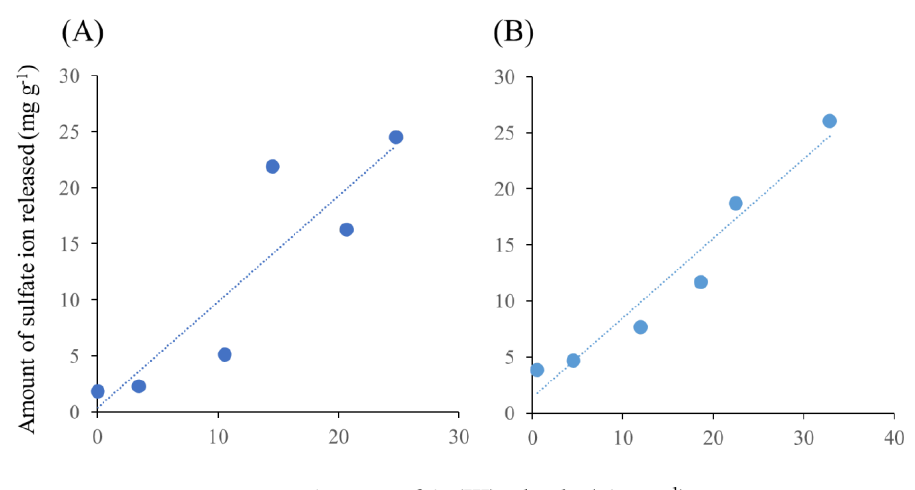
Figure 7. Relationship between amount of As(III) adsorbed and amount of sulfate ion released using NA11 ( A ) and NAZ1 ( B ). Initial concentration 1, 10, 30, 50, 70, and100 mg L − 1 , solvent volume 50 mL,